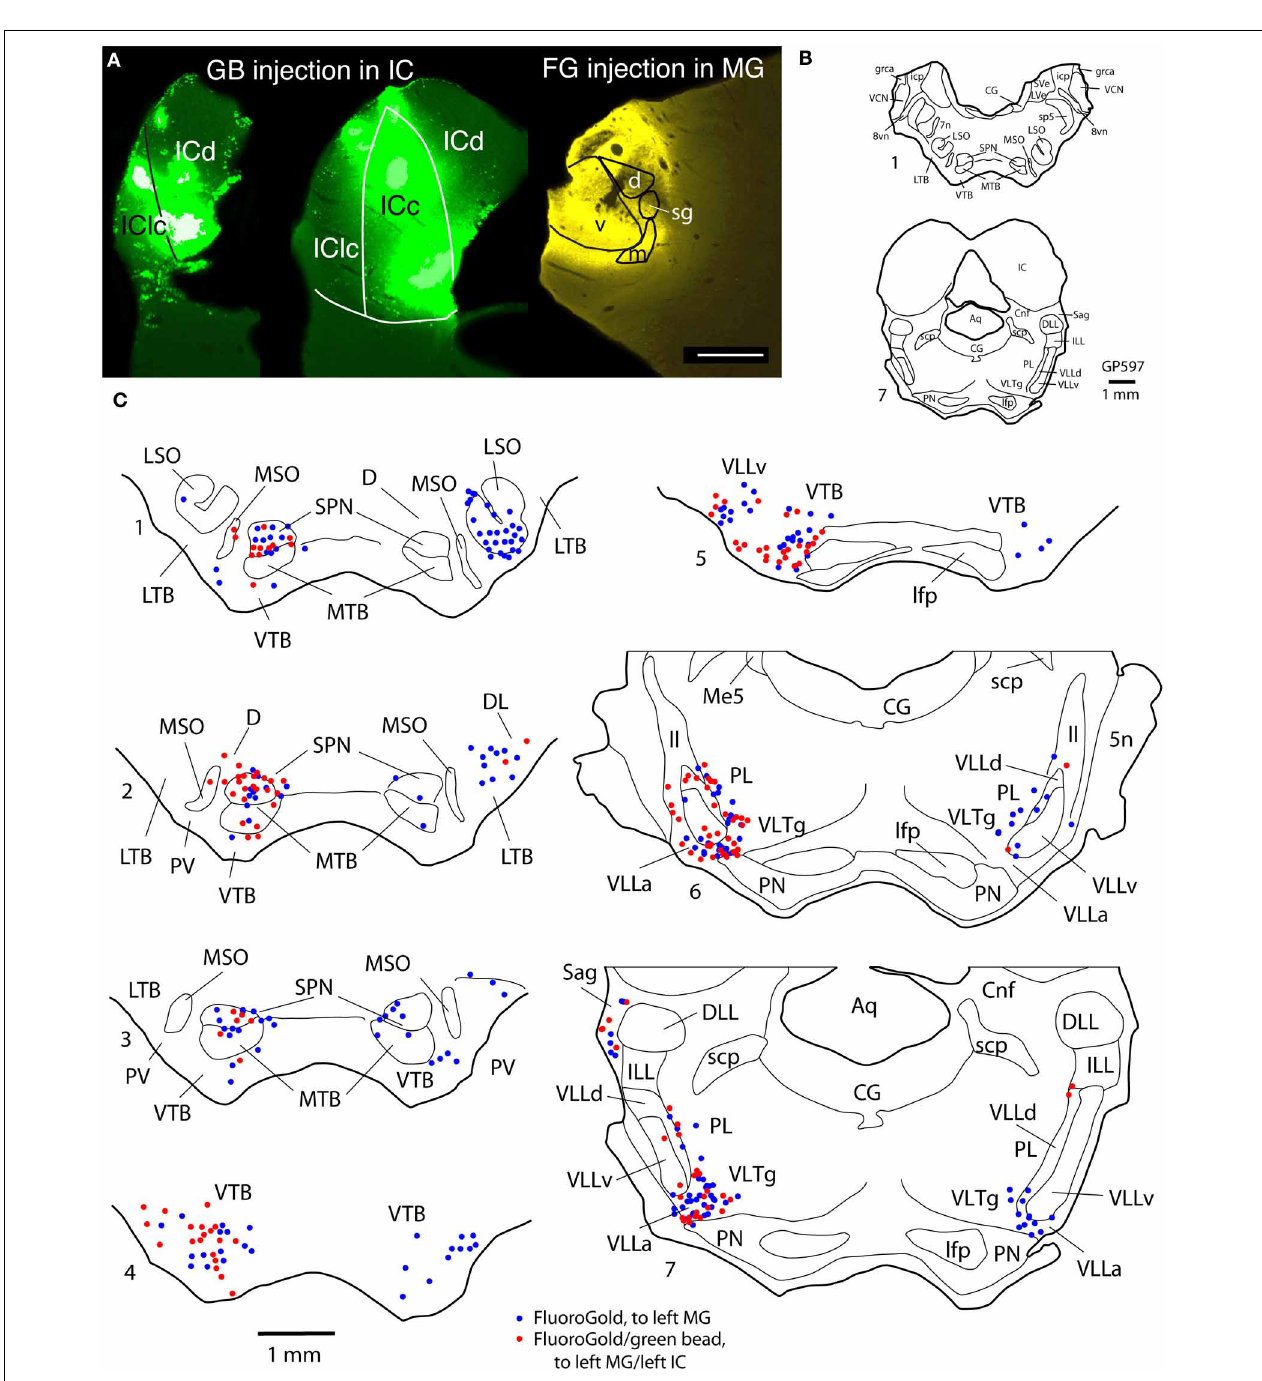
FIGURE 2 | Photographs and plots showing injection sites and the resultant distribution of labeled cells in transverse sections through brainstem auditory nuclei after injection of FluoroGold (FG) into the left MG and green beads (GB) into the left IC. (A) Photomicrographs showing dual injections of green beads into the IC and FluoroGold into the MG. Green beads were deposited at multiple sites in the left IC as shown here in a very caudal section (left section) and a more centrally located section (middle section). IC subdivisions are shown, illustrating the spread of green beads into the lateral cortex (IClc), the dorsal cortex (ICd) and the central nucleus (ICc). The right-most section shows a large injection of FluoroGold into the